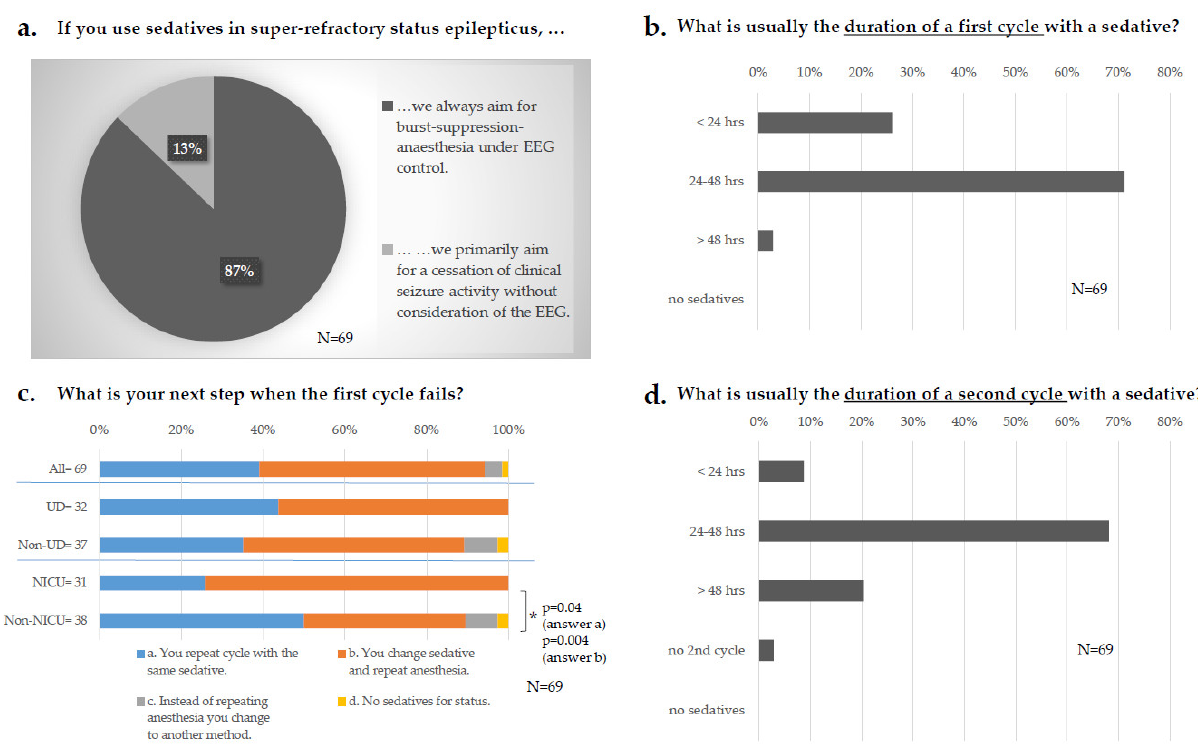
Figure 6. Super–refractory status. ( a ) Therapy goal under sedatives. ( b ) Duration of the first cycle with a sedative. ( c ) Next step after failure of the first cycle: upper bar: all participants answering the question (“all“); 2nd and 3rd bar: “all“ subdivided according to the level of care; 4th and 5th bar subdivided according to specialties. ( d ) Duration of the second cycle with a sedative. Data are displayed as percentage of survey participants answering this question. N = number of respondents, UD = university department; NICU = neurological/ neurosurgical ICU; hrs = hours; EEG = electroencephalography. * = significant; p-values were determined by paired difference test via Z tests and the Bonferroni correction;